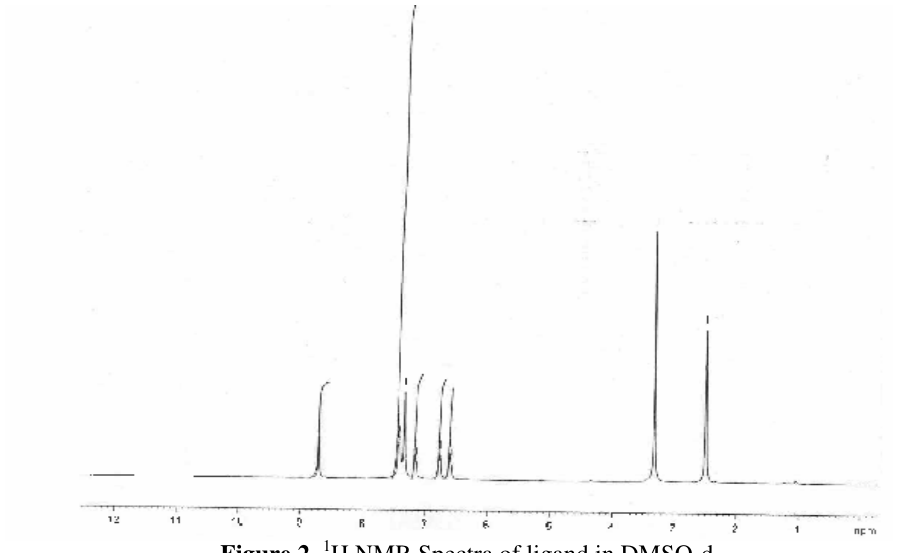
Figure 2. 1 H NMR Spectra of ligand in DMSO-d